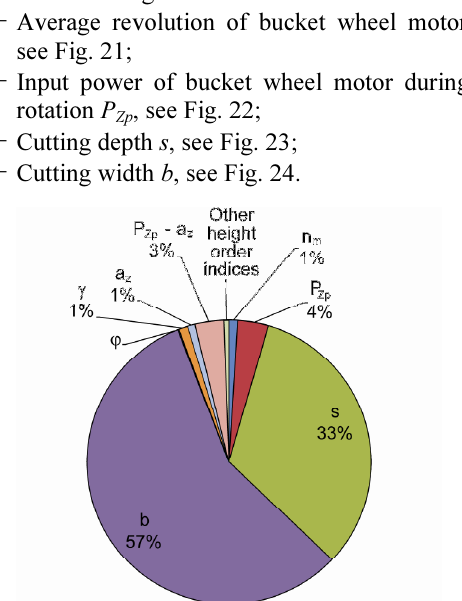
Fig. 17. Results for the first terrace ( P p is a non-random variable)